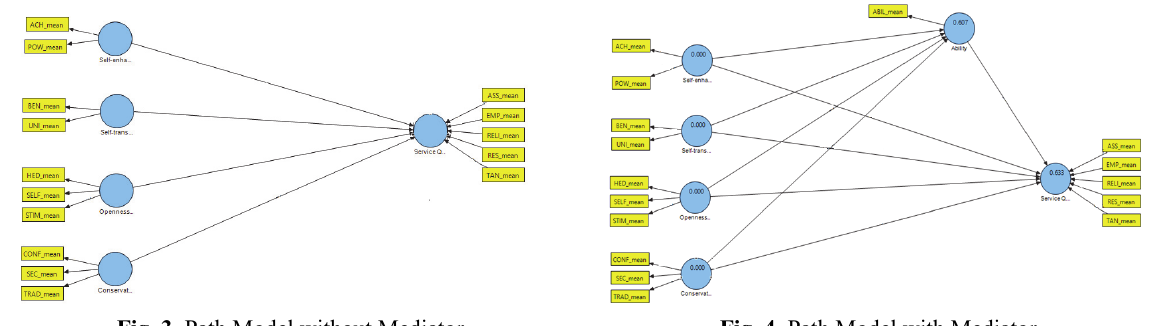
Fig. 3 . Path Model without Mediator Fig. 4 . Path Model with